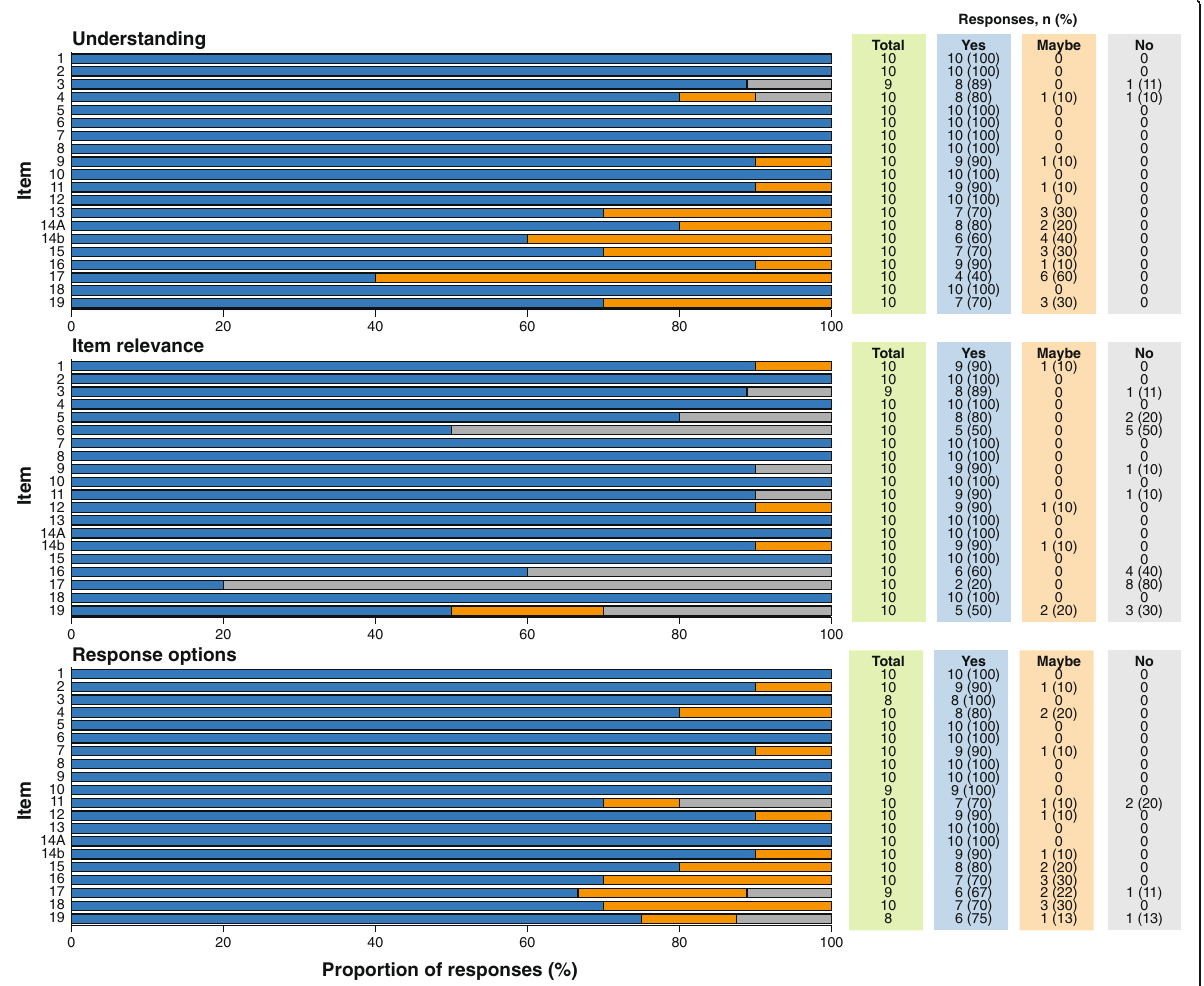
Fig. 3 Participant responses regarding the TASQ-IV items by item debrief; understanding, item relevance and response